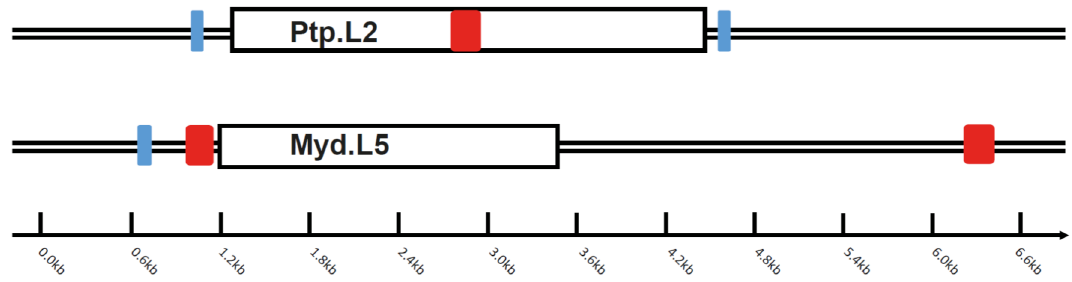
Figure 2. A pair of orthologous viral contigs in Parnell’s mustached bat and Brandt’s bat. The boxes with position 1.3–4.5 kb in Ptp.L2 and 1.2–3.5 kb in Myb.L5 represent viral element regions. The same color (blue and red) represents orthologous SINEs, where SINE-A1 and A2 are duplicates within Ptp and SINE-B1 and B2 are duplicates within Myd. The bar represents the contig length (in kilobase).